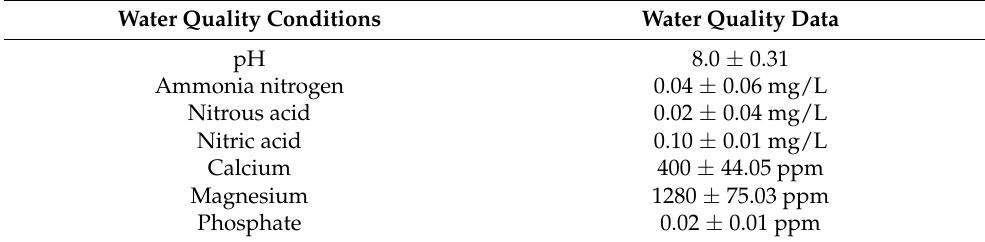
Table 1. The water quality conditions in the